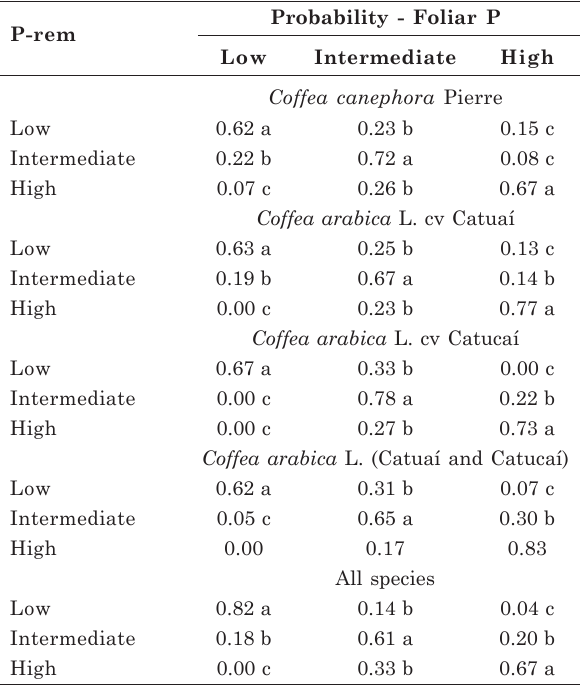
Table 5. Occurrence probability of foliar phosphorus groups (low, medium and high) within the remaining phosphorus groups (low, medium and high)